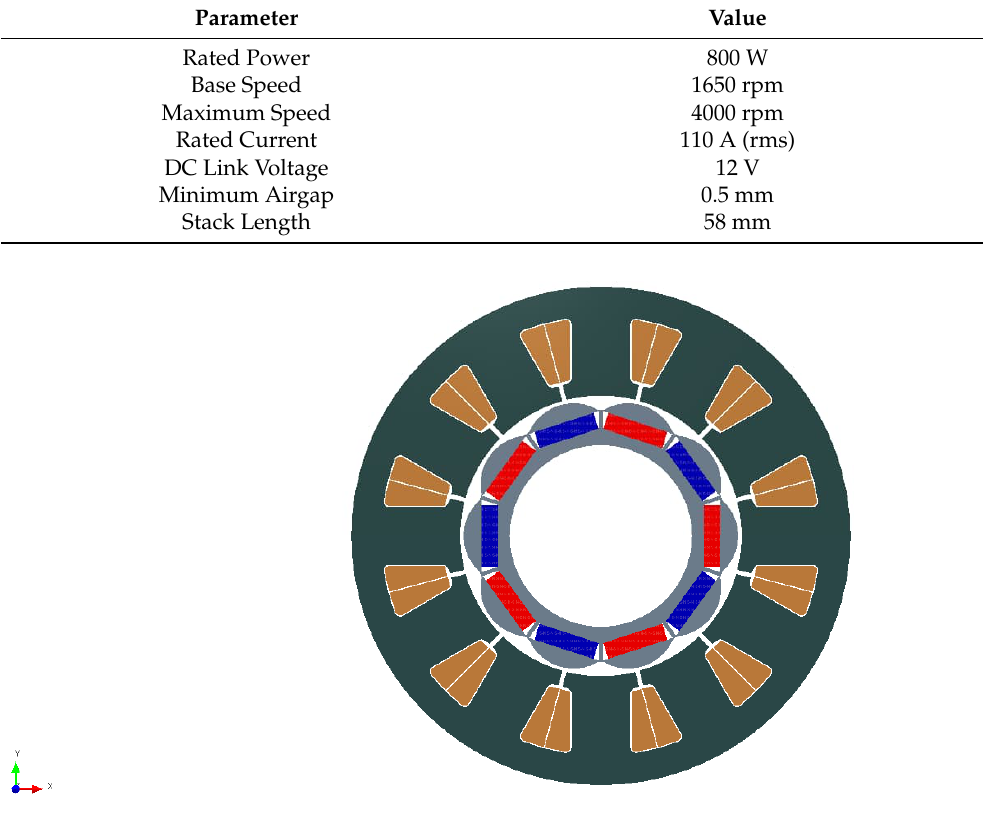
Figure 3. Cross section of the machine under study.